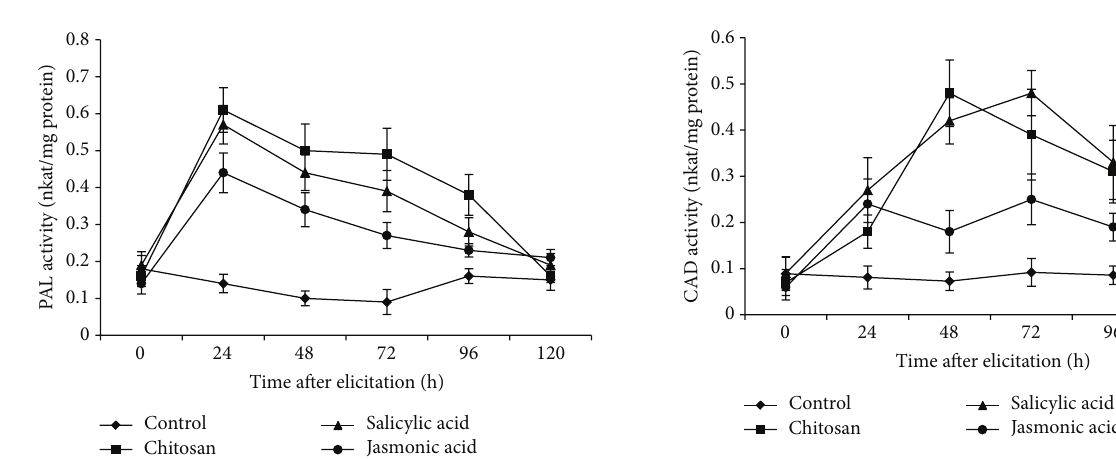
Figure 3: Phenylalanine ammonia lyase (PAL) activity (nkat/mg protein) on a time course after elicitation of the roots of tomato with different elicitors. Values are mean ± SD of triplicate analysis.